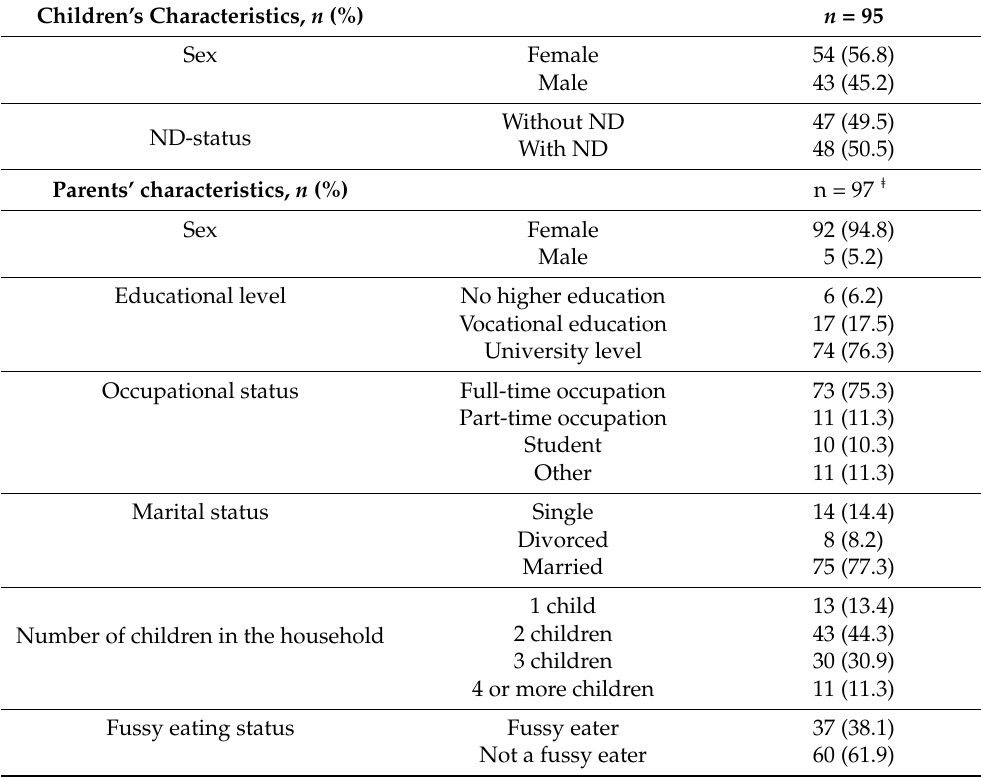
Table 2. Characteristics of parents and children in the study. Results are presented as n (%).